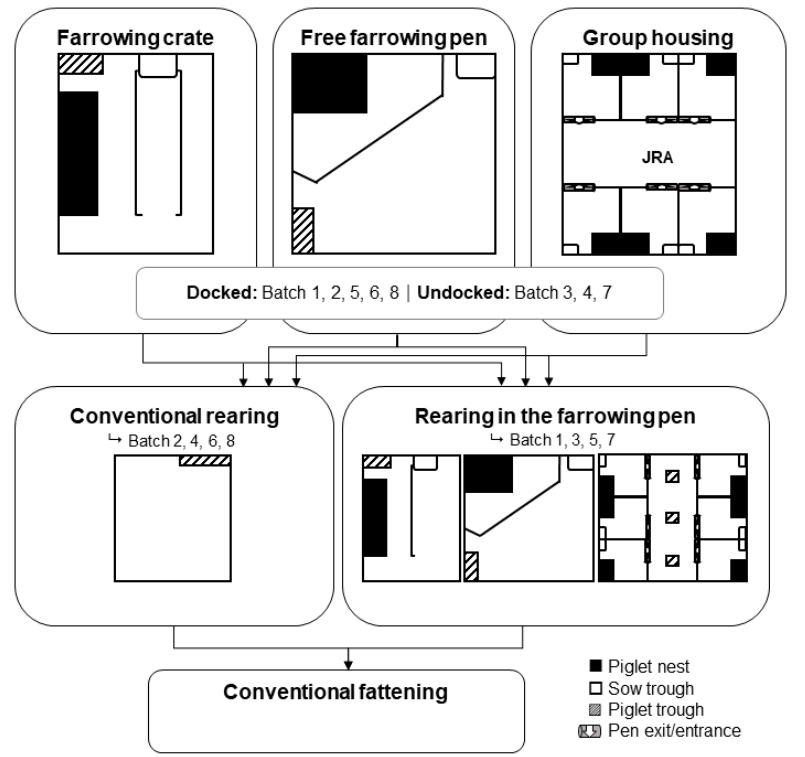
Figure 1. Schematic overview of the experimental design (JRA: joint running area; drawings are not to scale).